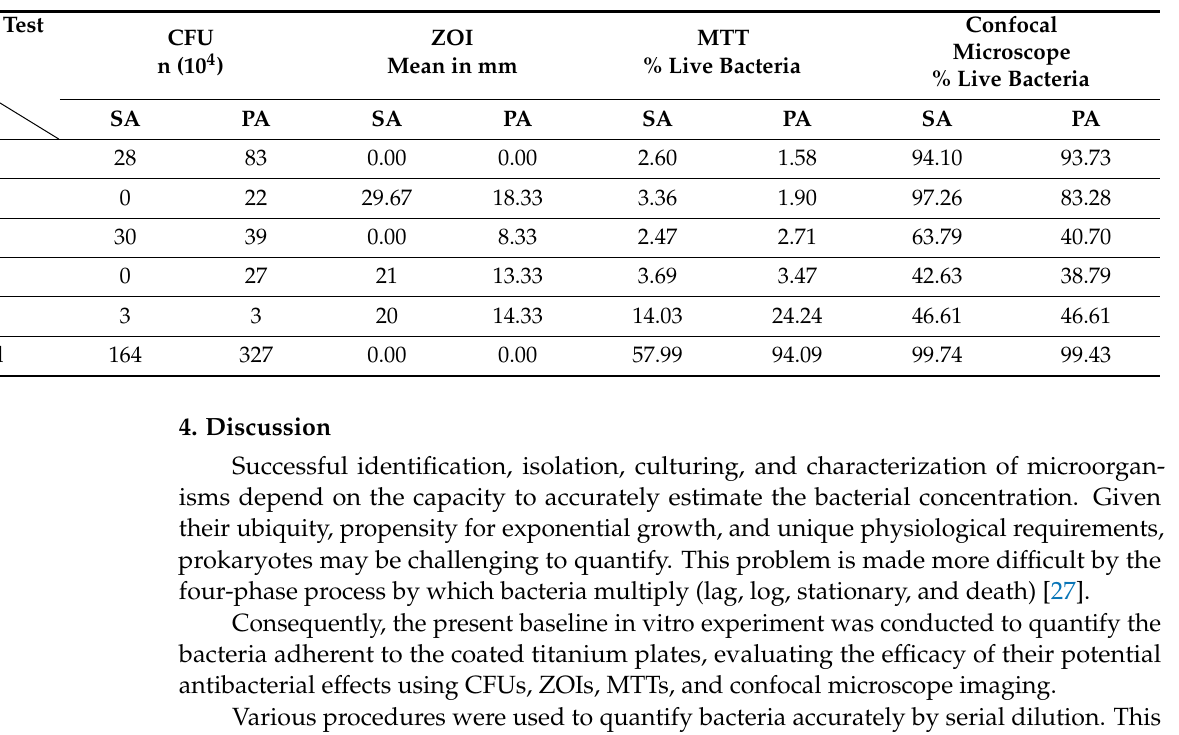
Table 5. Correlation between the different test methods against the coating materials and the two types of